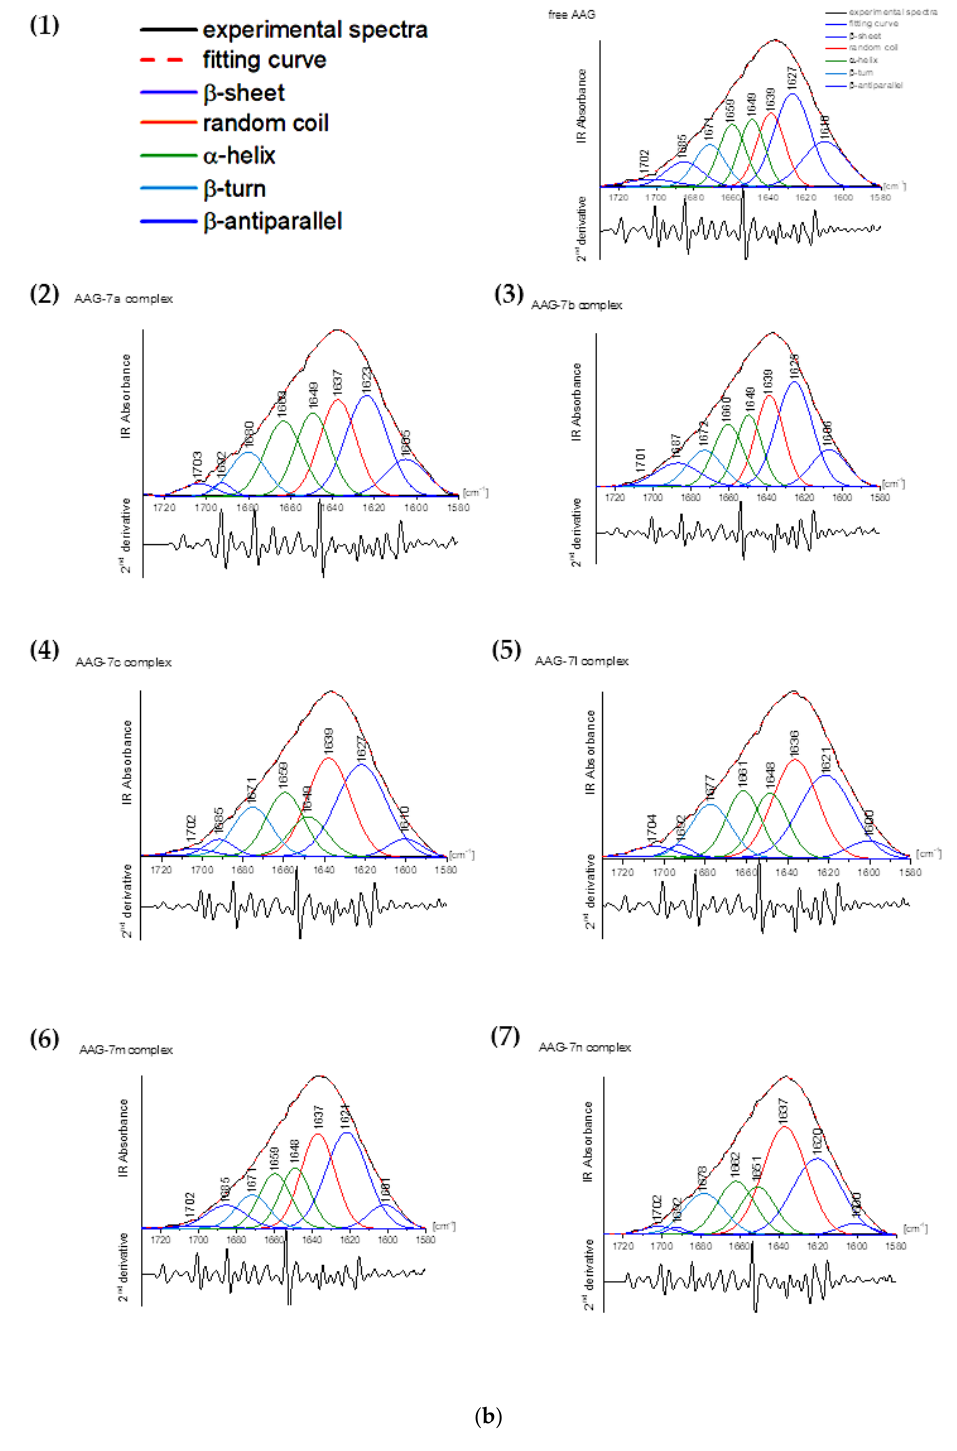
Figure 11. ( a ) Curve-fitted amide I region for: ( a1 ) free human serum albumin (HSA) and HSA complex with ( a2 ) 7a , ( a3 ) 7b , ( a4 ) 7c , ( a5 ) 7l , ( a6 ) 7m , and ( a7 ) 7n compounds. ( b ) Curve-fitted amide I region for: ( b1 ) free alpha-1-acid glycoprotein (AAG) and AAG complex with: ( b2 ) 7a , ( b3 ) 7b , ( b4 ) 7c , ( b5 ) 7l , ( b6 ) 7m , and ( b7 ) 7n compounds. The conformation of HSA is mostly dominated by α helix (64.55%), approximately 25.42% of β -sheet, and less than 1% of β -antiparallel shape (Table 13, Figure 11a).